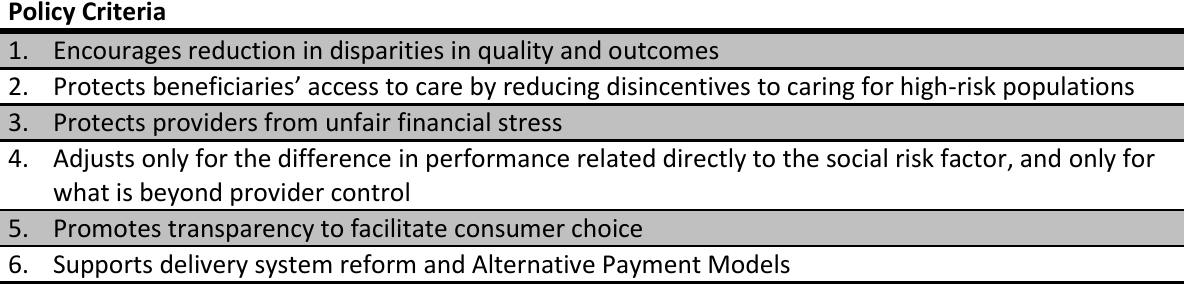
Table 6.11. Policy Criteria Policy